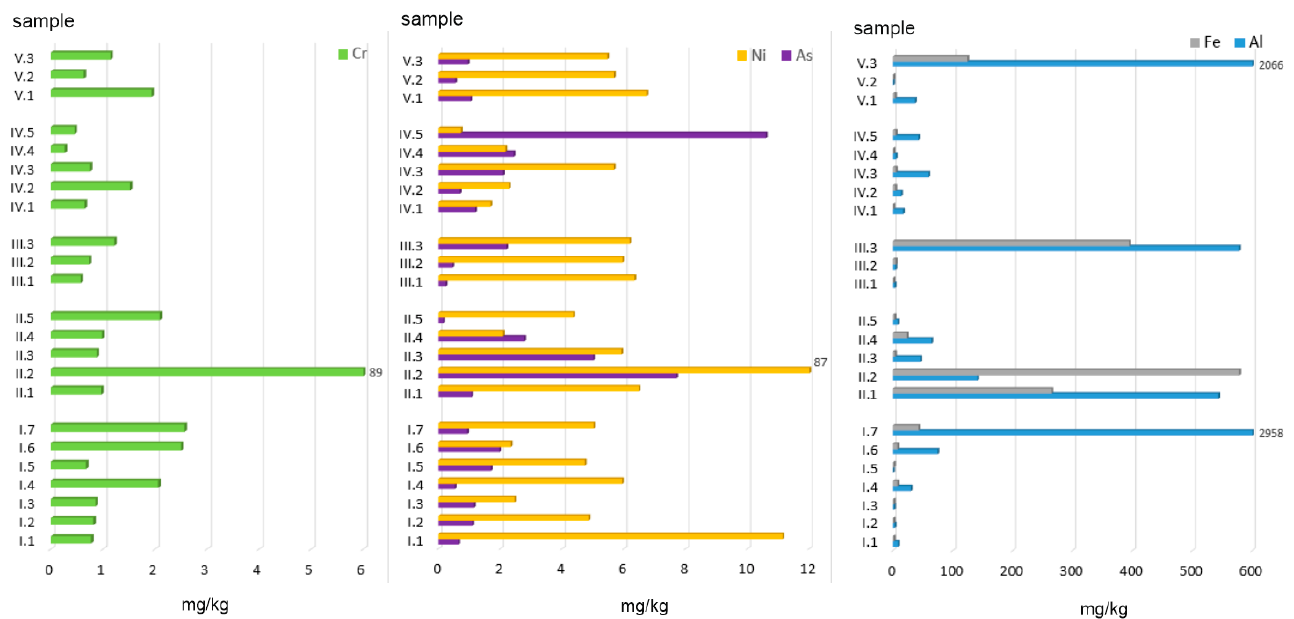
Figure 3. Ion- and carbonate-exchange fractions of PTEs in ashes burned in a household furnace. The highest amount of Al was extracted from alternative fuels, especially ashes ob- tained from the combustion of walnuts (958 mg/kg) and the mix of hard coal no. 1 with plastic packaging (2065 mg/kg). High quantities of ion-exchange Al, namely 543 and 578 mg/kg, were also observed for ashes from hard coal (no. 1 and no. 2) and hard coal mixed with acacia wood, respectively (Figure 3). For all the other samples, Al content did not exceed 100 mg/kg. Mean Al concentrations calculated for individual groups (as a % of the total concentration, %TC) can be arranged in the following order: AF (5.10) > MW + C (3.15) > AF + C (1.59) > C (0.30) > MW (0.08). The amount of Al found in the ion-exchange and carbonate-bound fraction in the material analysed was considerably lower and ranged between 0.15 and 10.59 mg/kg. The highest amount of Al was extracted from ashes obtained from diaper (10.59 mg/kg) and hard coal combustion (5.01–7.70 mg/kg for various types of coal). However, the conver- sion of the values to a percentage share in the total concentration revealed that Al was the most leachable element (data in %TC): MW (68) > AF (66) > MW + C (43) > AF + C (40) > C (29). Regarding Cr, the amounts extracted ranged from 0.27 to 88.89 mg/kg, with the high- est concentration found in ashes obtained from hard coal no. 2 and the lowest in those from plastic-coated paper cartons (Figure 3). The content of Cr in F1—ion-exchange and carbonate-bound fractions in individual ash groups can be arranged in the following or- der (data in %TC): C (37) > MW + C = AF (4) > AF + C (3) > MW (2.5). Fe displayed highly diverse concentrations with regard to its absolute and relative amounts extracted with acetic acid from the material analysed. The highest amounts of this element in the exchange and carbonate fraction were found in ashes obtained from the combustion of hard coals (265.02–578.76 mg/kg) and coals mixed with acacia wood (394 mg/kg) and with plastic packaging (124 mg/kg). With regard to the mean Fe content expressed as a percentage share in the total concentration, the material analysed can be arranged in the following order (data in %TC): AF + C (0.75) > C (0.64) > MW + C (0.23) > AF (0.07) > MW (0.06). The last element analysed was Ni. Its amount extracted in F1 BCR ranged from 0.72 to 86.90 mg/kg, with the highest values observed for ashes obtained from hard coal no. 2 (86.90 mg/kg) and acacia wood (11.13 mg/kg). The lowest Ni content (0.72 mg/kg) was